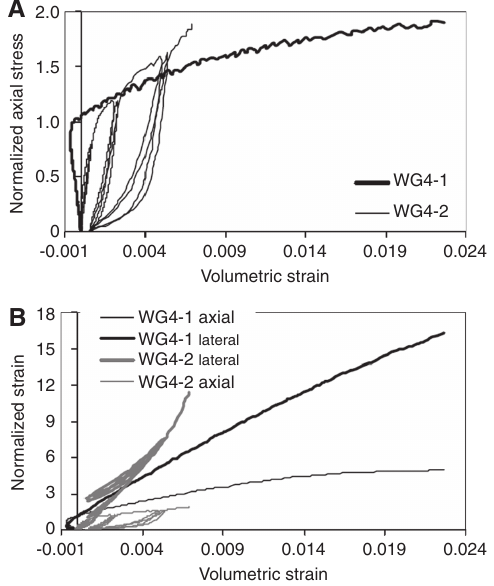
Figure 11 Normalized ultimate axial stress versus the modified effective confinement index α ′ ω w